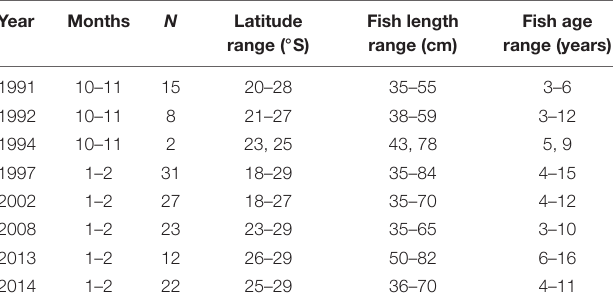
TABLE 1 | Sample sizes ( N ), age and length ranges of Merluccius paradoxus used for the final dataset of the otolith biochronology, sampled during Namibian hake biomass surveys 1991 to